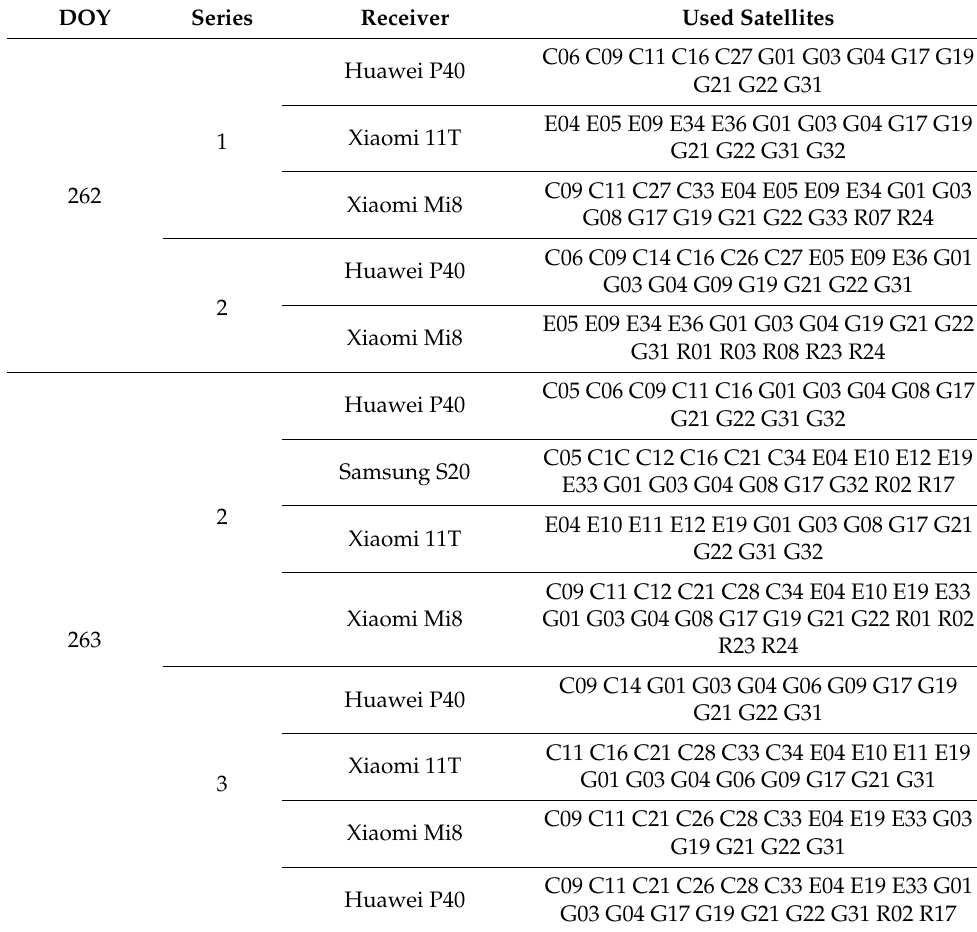
Table 10. Used combinations of satellite-receiver for the calculation of the time of approach (C stands for BeiDou, E for Galileo, G for GPS, and R for GLONASS satellites on their respective frequency bands B1, E1, L1, and